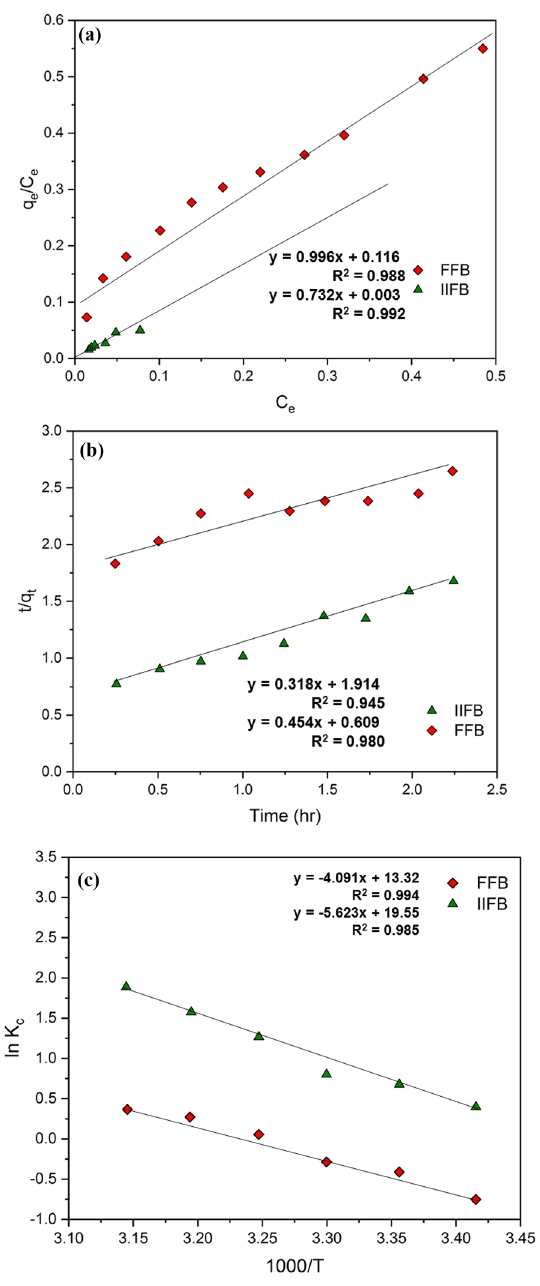
Figure 6. ( a ) Langmuir isotherm plot for As(III) by FFB and IIFB. ( b ) Plot of Pseudo-second-order rate kinetics model for As(III) removal through FFB and IIFB. ( c ) Van’t Hoff plot for As(III) biosorption over FFB and